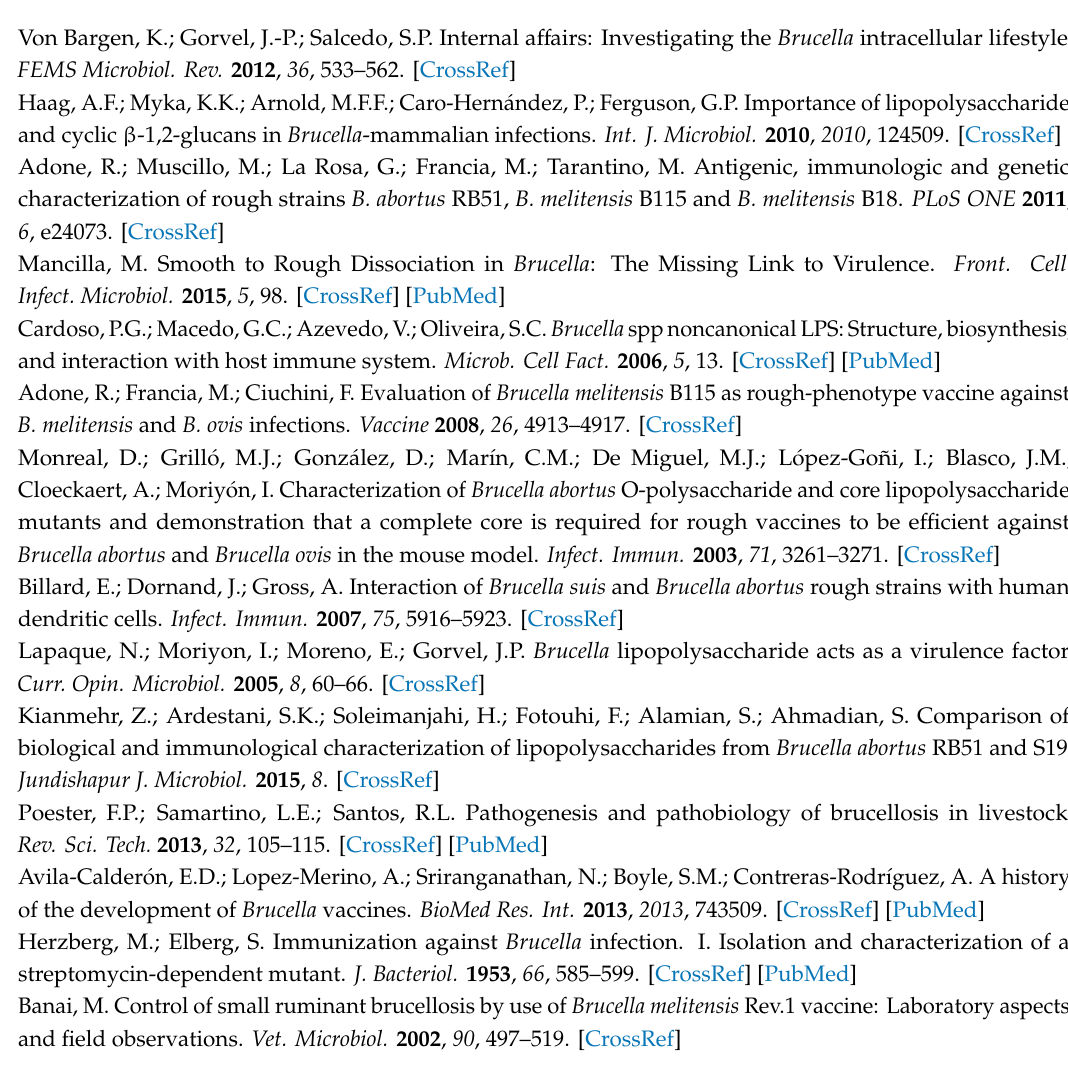
Figure S1: Missense mutation within NAD(P) transhydrogenase subunit alpha protein, Figure S2: Missense mutation within Magnesium transporter, Figure S3: Missense mutation within the MFS transporter protein, Figure S4: In vitro stress survival of the natural rough B. melitensis Rev.1 71036 and 44457 vaccine strains, Table S1: List of Bacterial strains used for this study, Table S2: List of genomic